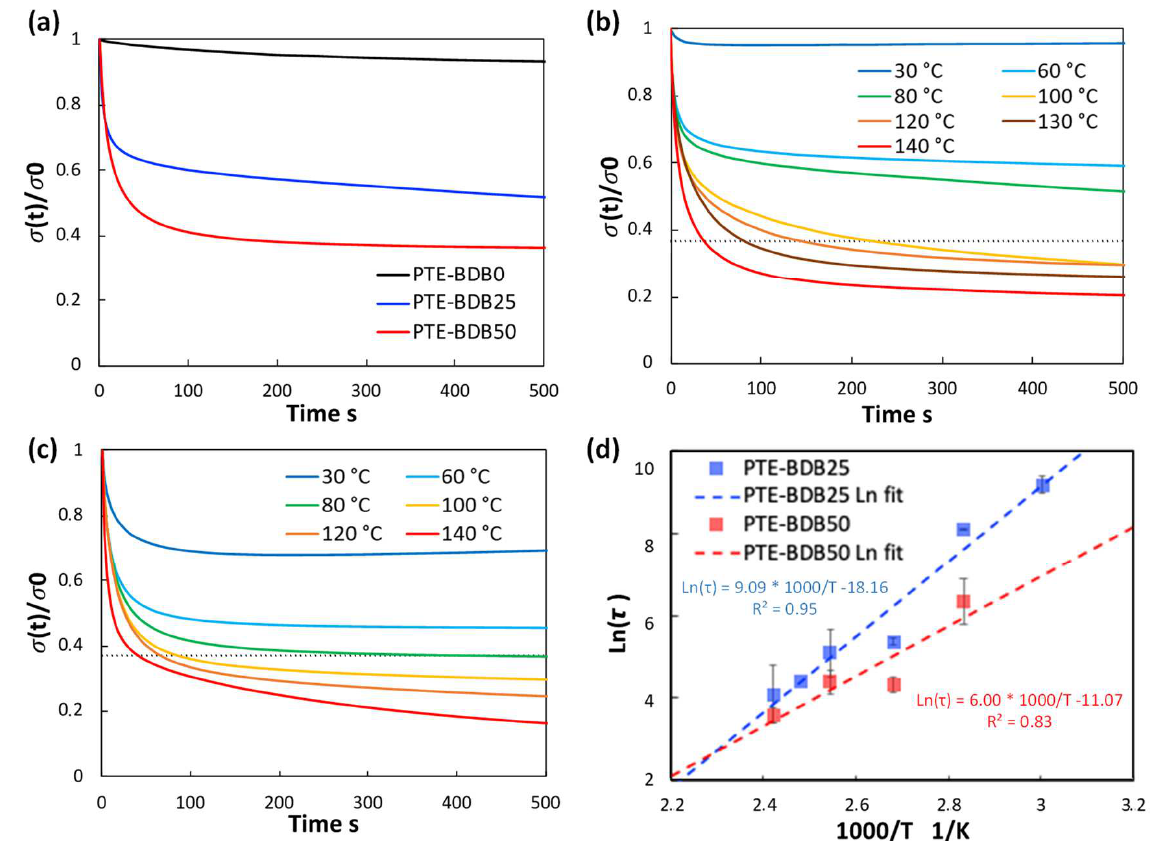
Figure 3. ( a ) Stress relaxation behaviors of PTE-BDB samples with 0, 25, and 50 mol% of BDB dynamic chain extender at 80 °C; ( b ) Stress relaxation curves of PTE-BDB25 sample at different temperatures; ( c ) Stress relaxation curves of PTE-BDB50 sample at different temperatures; ( d ) Arrhenius linear fit of relaxation times of PTE-BDB25 and PTE-BDB50 samples plotted as a function of 1000/T.